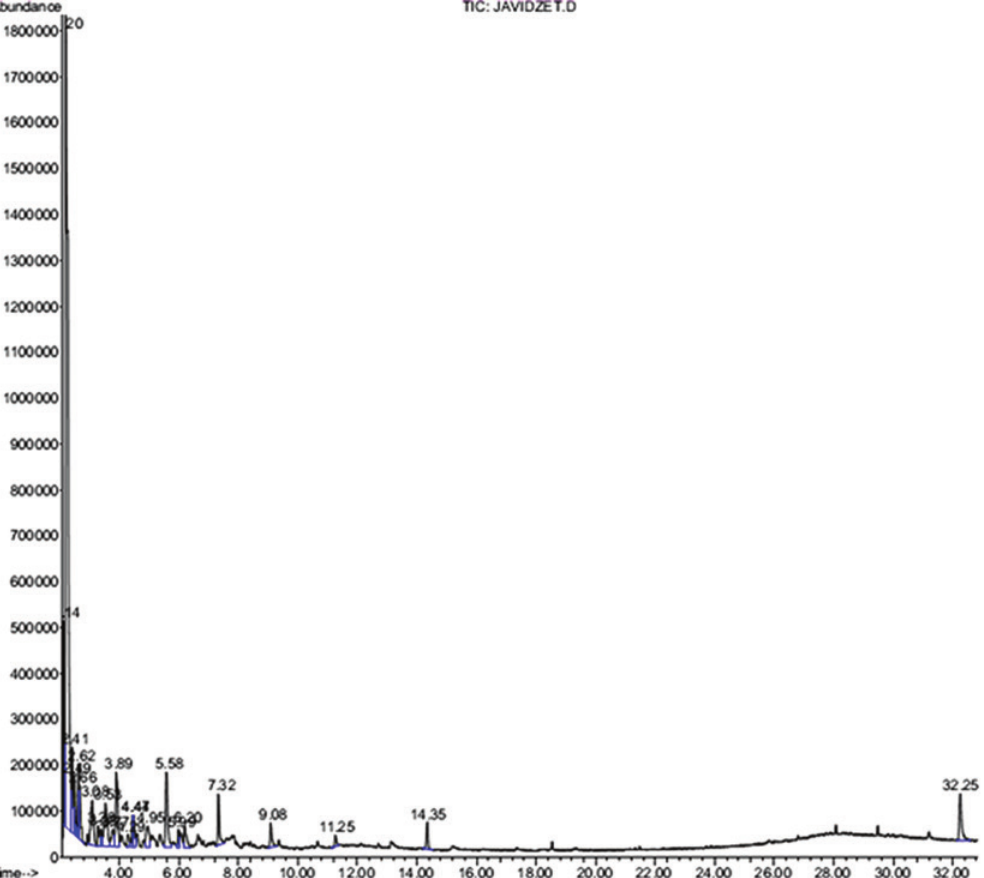
Figure 2: GC-MS chromatogram of barberry